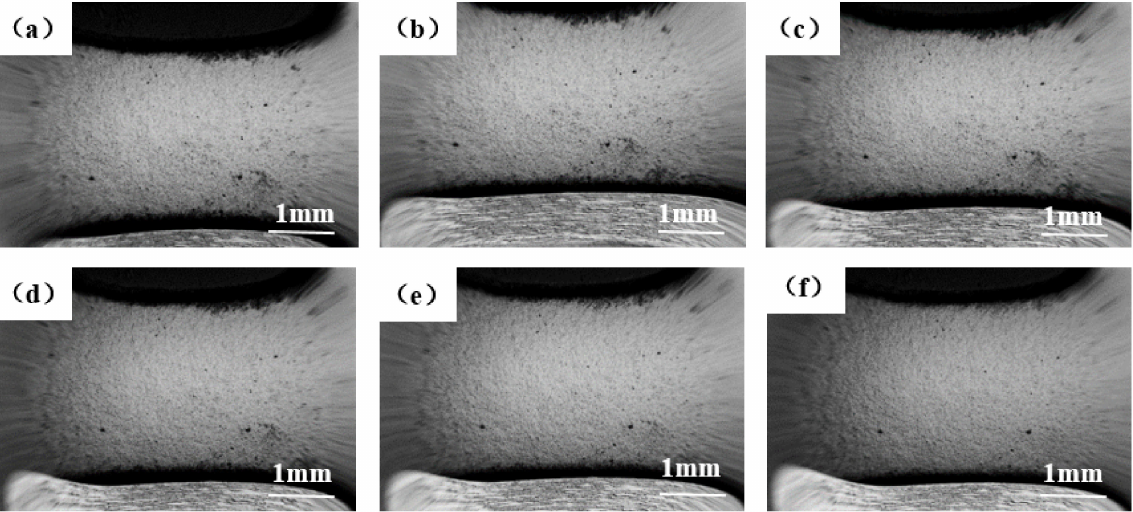
Figure 3. In situ SEM images of specimens at different temperatures without load: ( a ) 111 ◦ C;